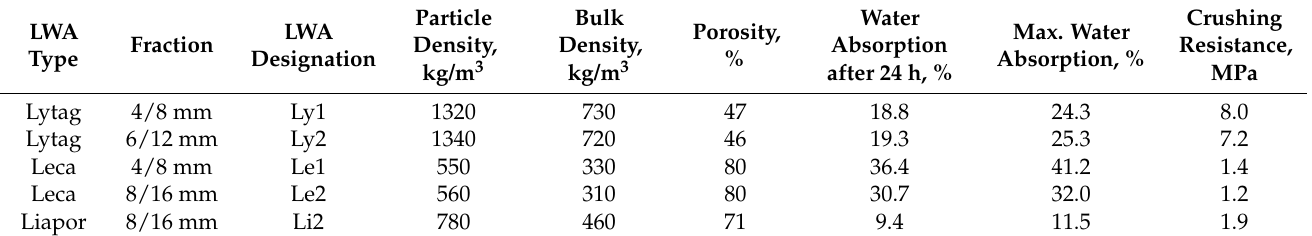
Figure 1. Types of lightweight aggregates used for the research. Table 1. Properties of lightweight aggregates used in the research.